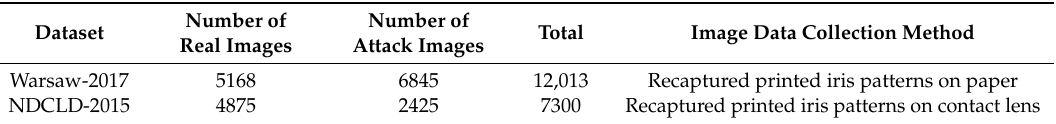
Table 3. Description of Warsaw-2017 and NDCLD-2015